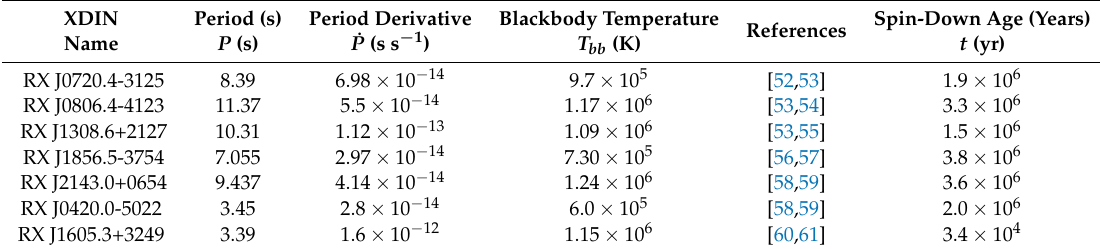
Table 1. Observational data for Isolated X-ray Neutron Stars